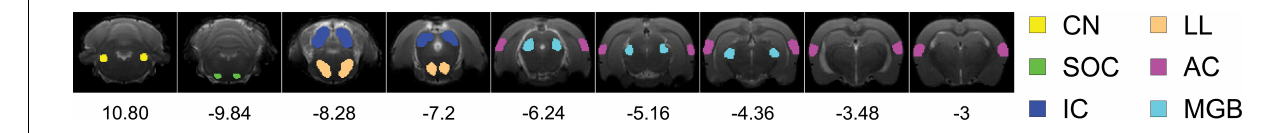
FIGURE 2 | Regions of interest (ROIs) used in the blood-oxygenation-level dependent (BOLD) percent signal change computation. Six Regions of interest (ROIs) were manually drawn using a rat brain atlas as reference. The BOLD percent signal change was calculated for these regions. The distance from bregma is displayed below each anatomical magnetic resonance imaging (MRI) brain